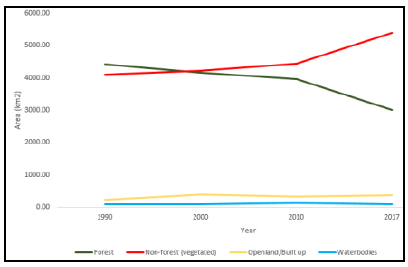
Figure 3. Land use change trend from 1990 to 2017